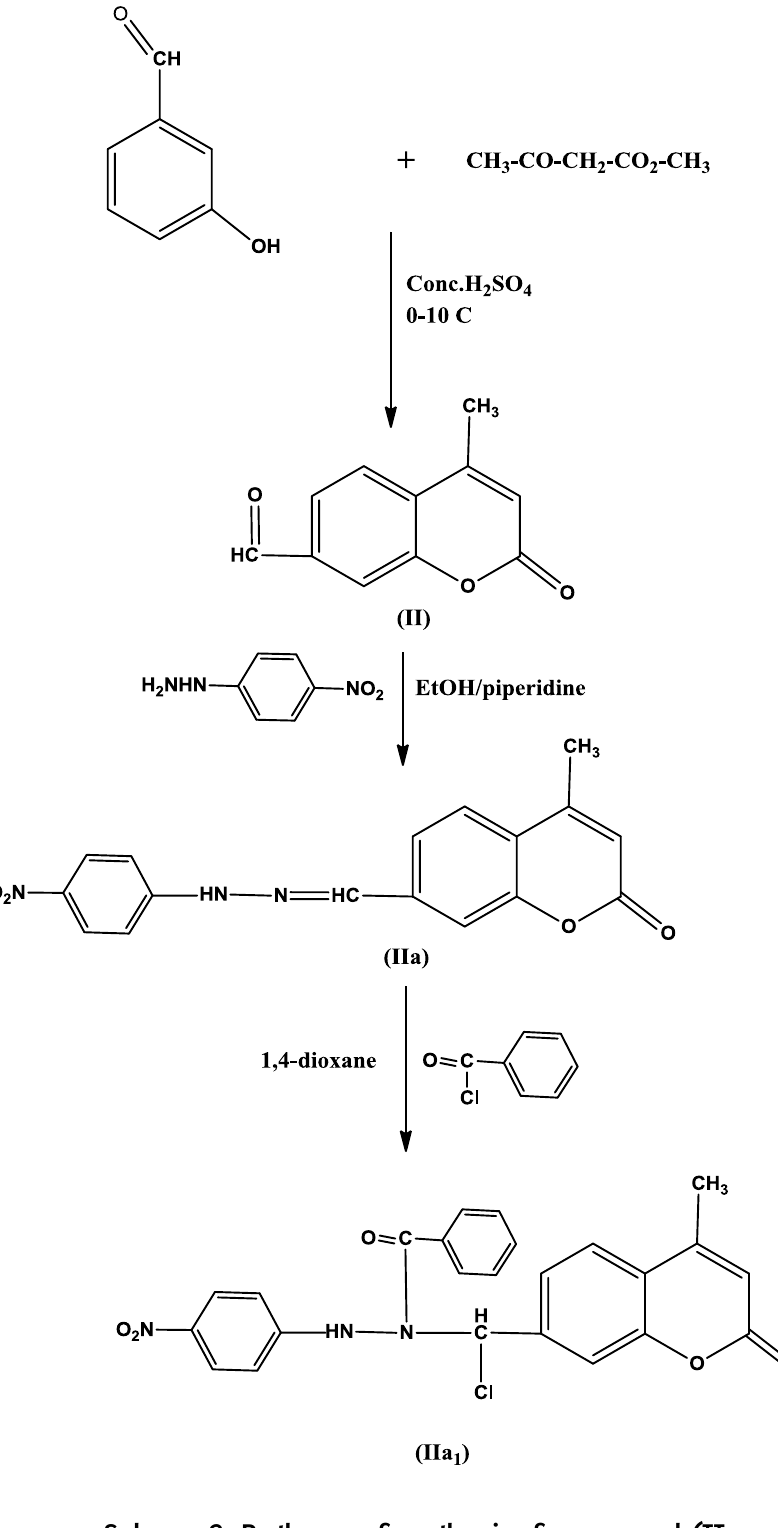
Scheme 2: Pathway of synthesis of compound (IIa